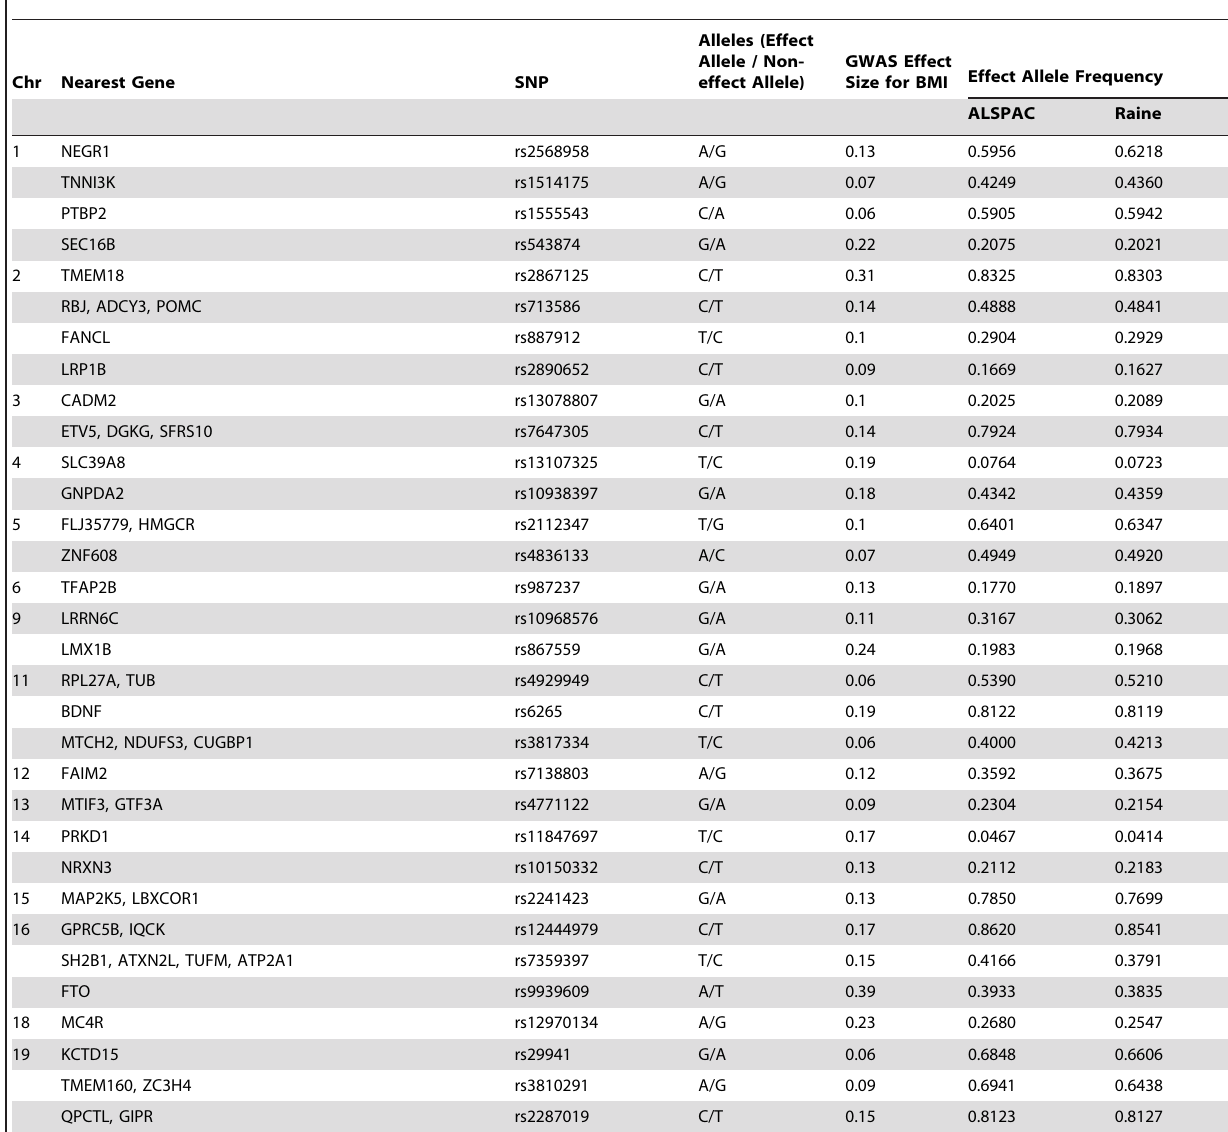
Table 2. Descriptive statistics of the single nucleotide polymorphisms included in the allelic